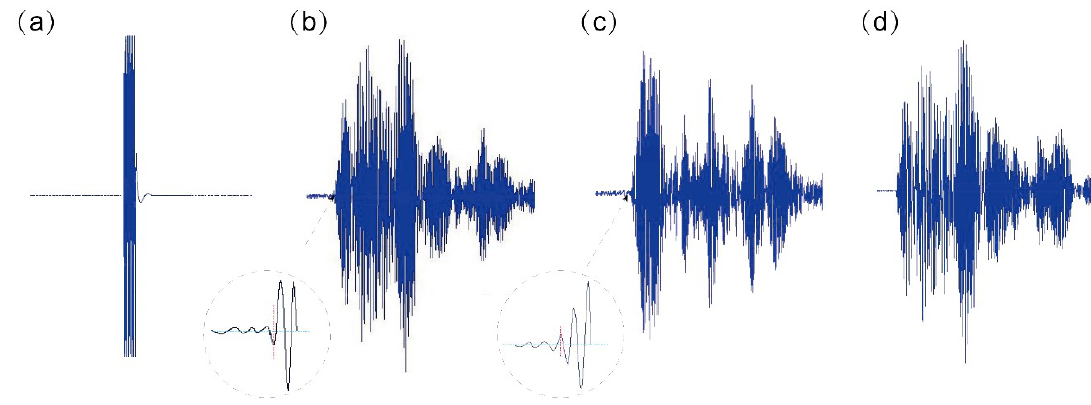
Figure 4. Characteristics of different types of waveform: ( a ) a excited ultrasonic waveform; ( b ) a received P-wave waveform; and, ( c ) a received S-wave waveform; ( d ) a received AE waveform; the blue dotted line is the symmetrical centerline of the waveform; the red dotted line is the recorded time of arrival of ultrasonic signal.